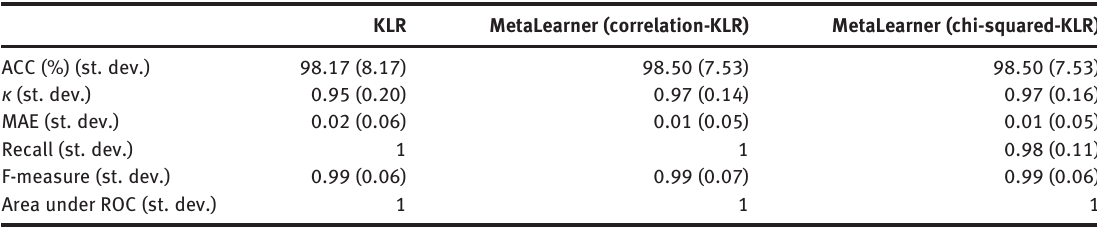
Table  : Results achieved with  -fold cross-validation. KLR MetaLearner (correlation-KLR) MetaLearner